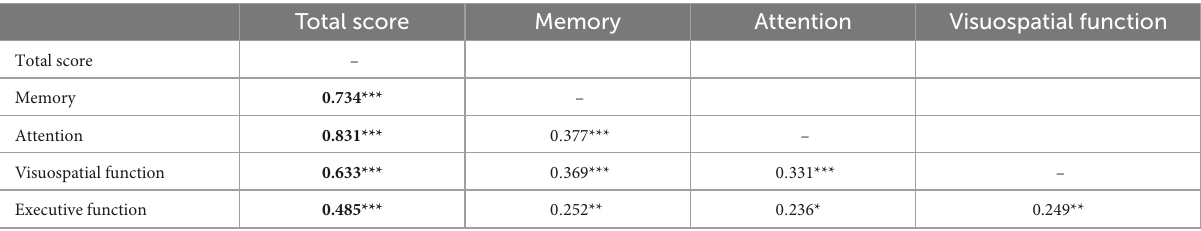
TABLE 6 Correlation coefficients between each cognitive domain and total score of VARABOM test. Total score Memory Attention Visuospatial